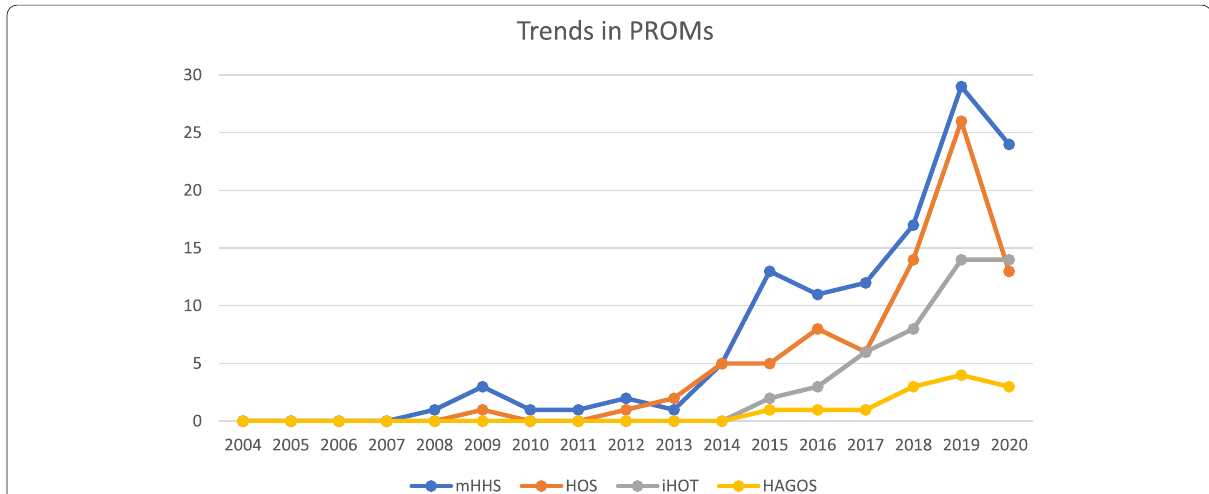
Fig. 3 Trends in the number of recommended PROMs for FAIS and the most commonly used mHHS Abbreviations: HAGOS: The Copenhagen Hip and Groin Outcome Score, HOS: Hip Outcome Score, iHOT: international Hip Outcome Tool, mHHS: modified Harris Hip score, PROM: Patient-reported Outcome Measure. *Note the year 2020 only covers studies until search day 7 th of